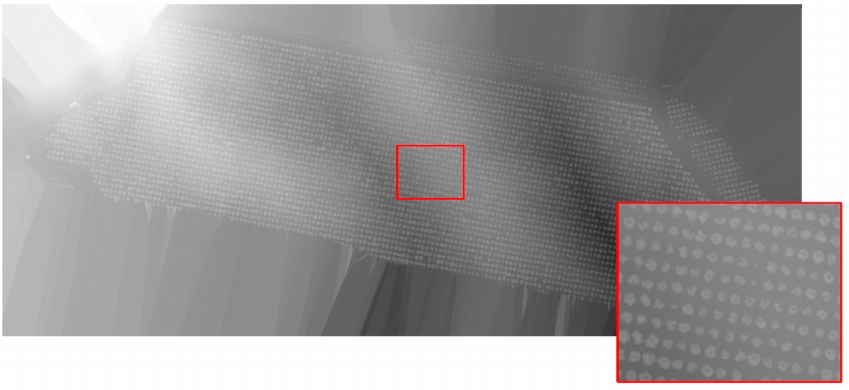
Figure 5. Representation of the computed DSM as the intensity image GS DSM . Note in the zoomed area, highlighted in the red square, the di ff erences in terms of grey level between those pixel regions which apparently belong to olive trees, and those from the surrounding ground. Then, given that each pixel intensity value is assigned according to its elevation in the DSM, higher pixel values indicate higher altitudes with respect to the sea level. It should be noted that, for the sake of facilitating its visualisation, the image display range has been established between the minimum bigger-than-zero value from the DMS, and its